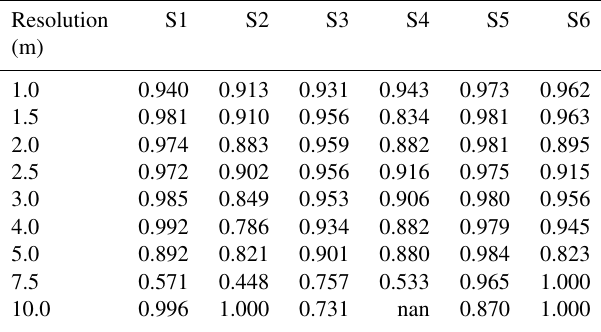
Table A3. Table of sensitivity for sites S1 to S6 (columns) with no Wiener filter, for resolutions varying between 1 and 10m (rows). The term “nan” indicates “not a number”.